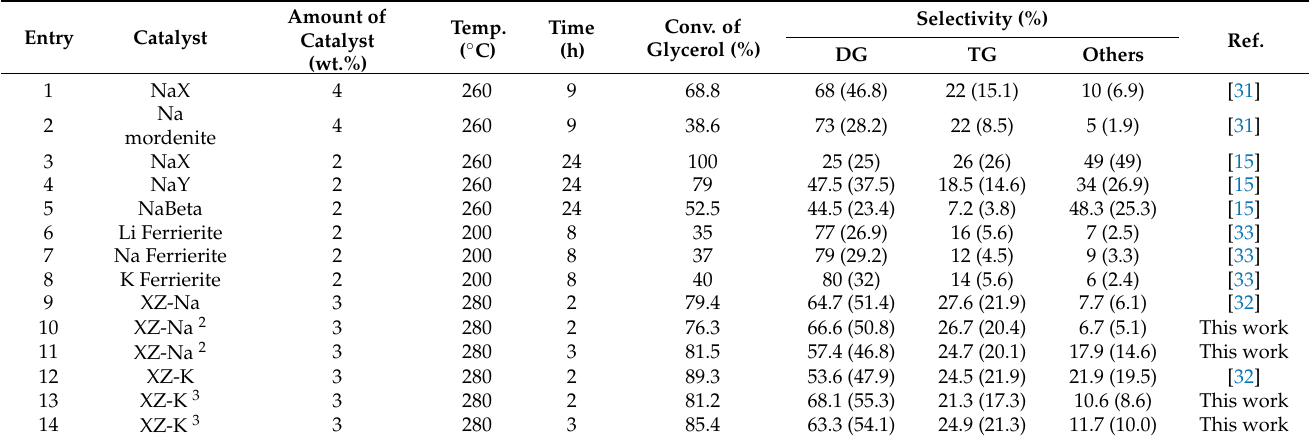
Table 1. Comparison of the catalytic activity of heterogeneous catalysts containing alkali metal cation in the etherification reaction of glycerol 1